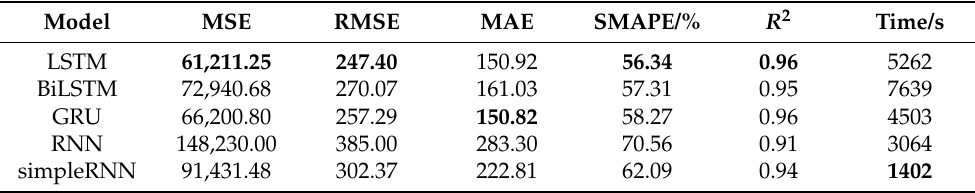
Table 2. Performance comparison of basic neural network models.